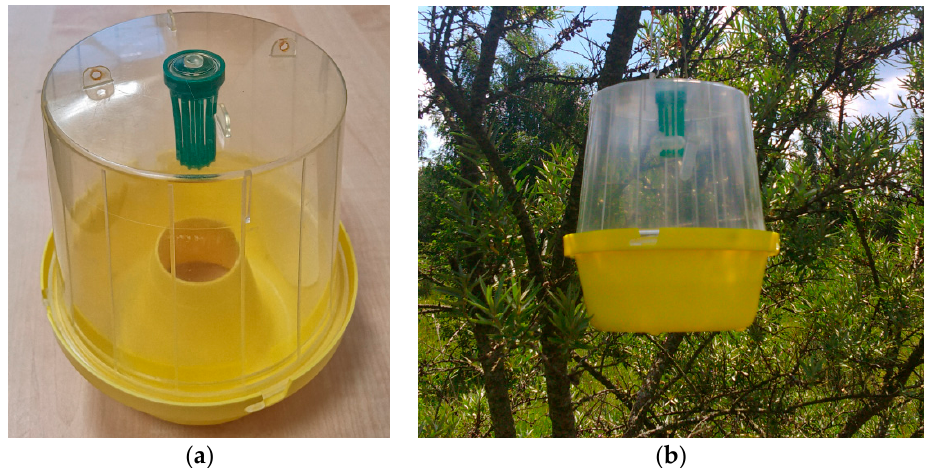
Figure 2. The McPhail trap: ( a ) empty trap and ( b ) trap fixed on the branch of sea buckthorn ( Hippophae rhamnoides ).